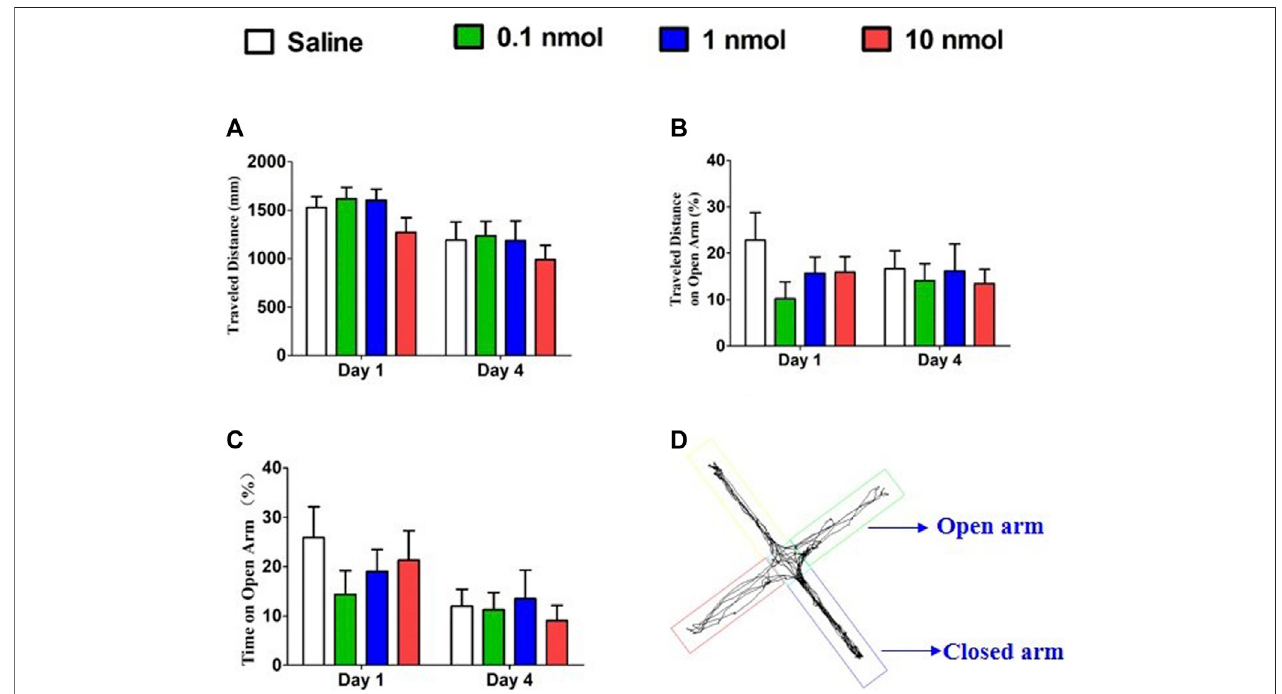
FIGURE 10 | Effects of α -conotoxin TxIB in the elevated plus maze test. Data are presented as the mean ± SEM, n (cid:1) 8 – 10. (A) The distance traveled by different groups onthe fi rst andfourth days.ANOVA: Day1,F 3,32 (cid:1) 1.63, p (cid:1) 0.20;Day 4,F 3,34 (cid:1) 0.43, p (cid:1) 0.73. (B) Thepercentage oftravel distance intheopen armofdifferent groups on the fi rst and fourth days. ANOVA: Day 1, F 3,32 (cid:1) 1.39, p (cid:1) 0.26; Day 4, F 3,34 (cid:1) 0.15, p (cid:1) 0.93. (C) The percentage of time spent in the open arm of different groups on the fi rst and fourth days. ANOVA: Day 1, F 3,32 (cid:1) 0.72, p (cid:1) 0.55; Day 4, F 3,34 (cid:1) 0.22, p (cid:1) 0.88. (D) The traces of mice during elevated plus maze test.